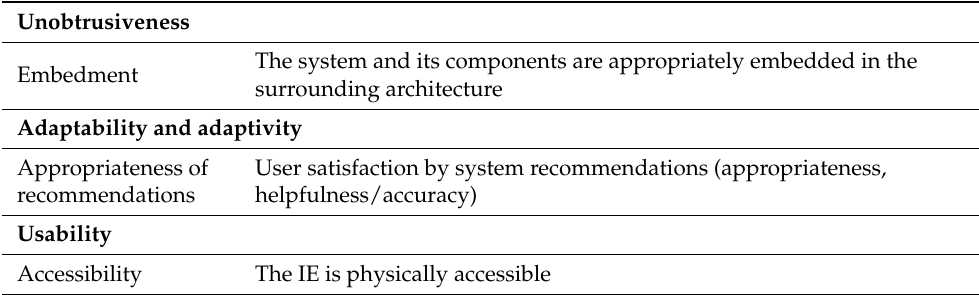
Table A6. UXIE metrics to be assessed through interviews shortly after a user-based